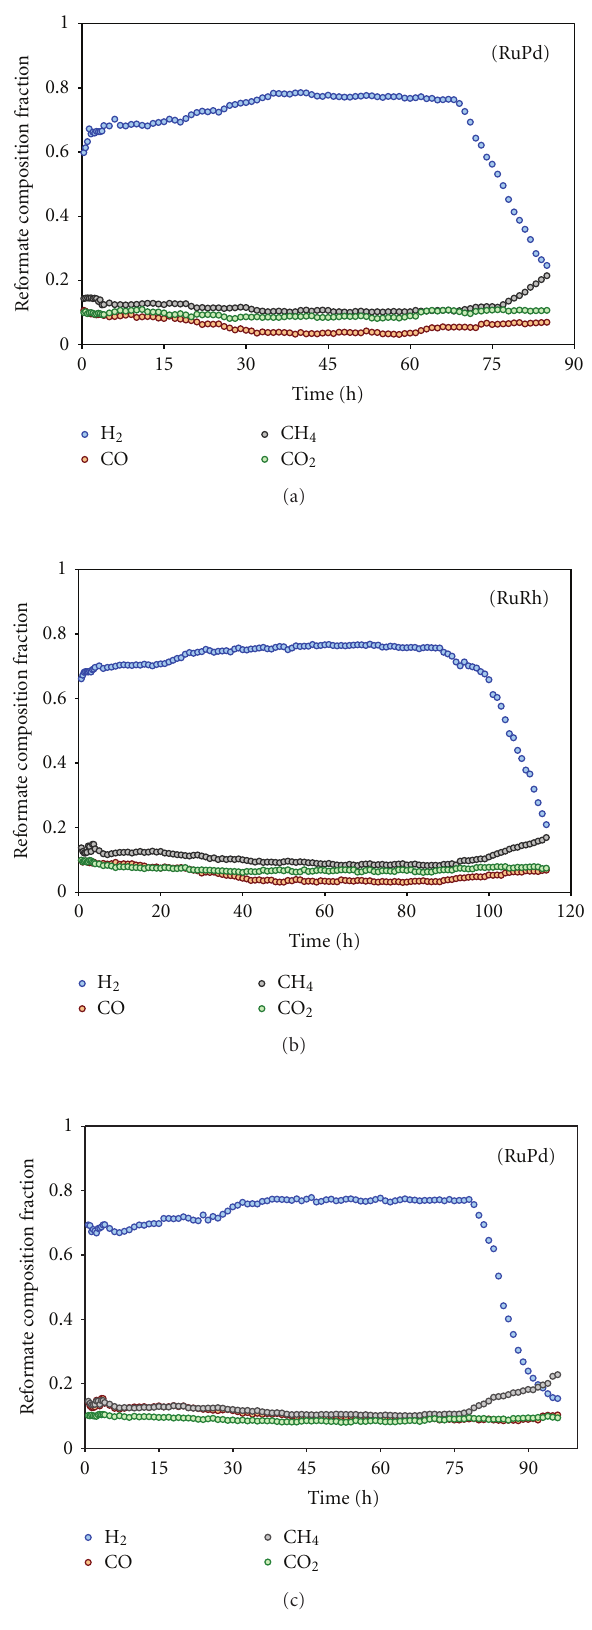
Figure 7: Composition of kerosene reformates with the three bimetallic catalysts.